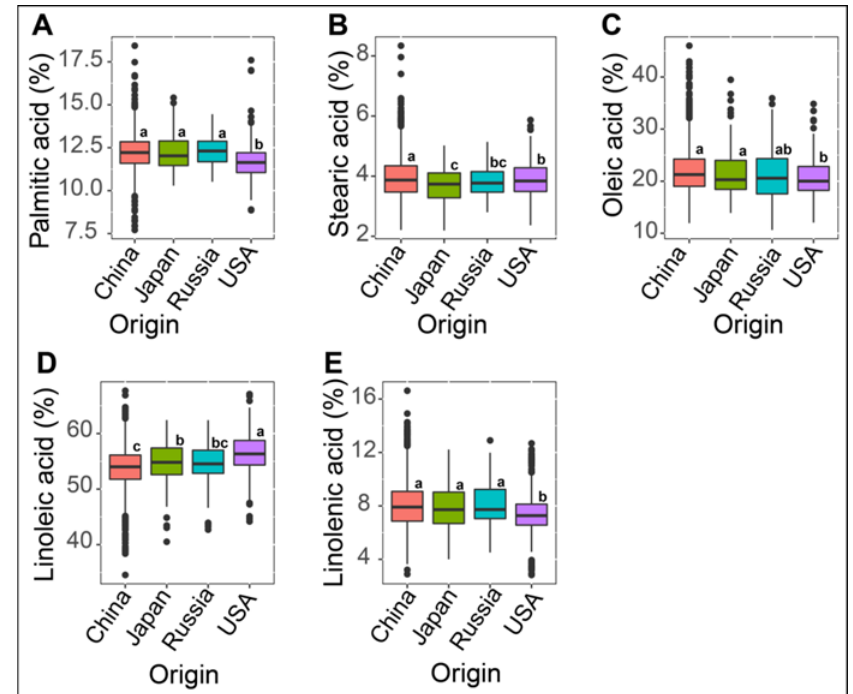
Figure 1. Boxplots of five fatty acid composition of 633 soybean accessions collected from four di ff erent germplasm origins (averaged across three locations and two years). ( A ) palmitic acid (PA), ( B ) stearic acid (SA), ( C ) oleic acid (OA), ( D ) linoleic acid (LA), and ( E ) linolenic acid (LNA). Di ff erent lowercase letters (a, b, and c) at the top of each boxplot indicate statistically significant di ff erences at P < 0.05 level among the four germplasm origins.